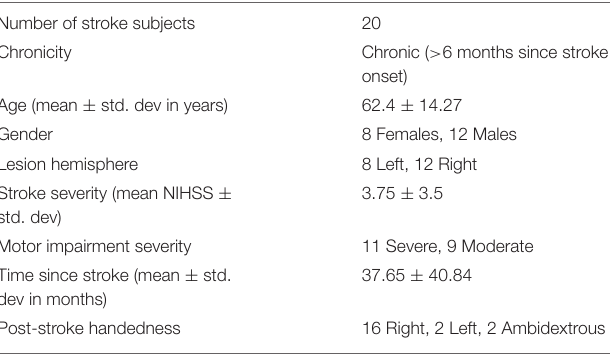
TABLE 1 | Demographic and clinical characteristics of the study